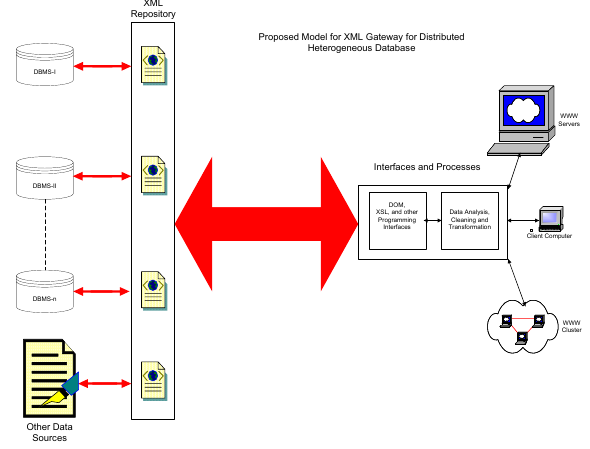
Figure 2: XML Gateway Architecture of Heterogeneous Management Database